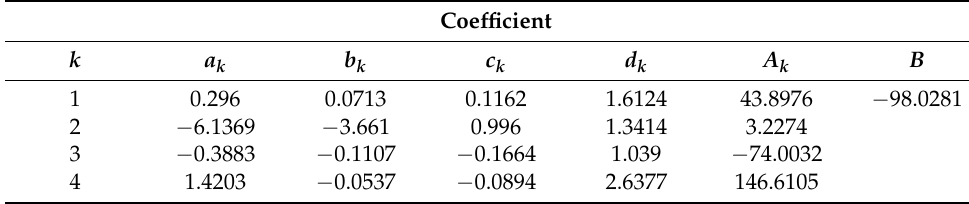
Table 3. Coefficient of Equation (8) for ANN1 model.